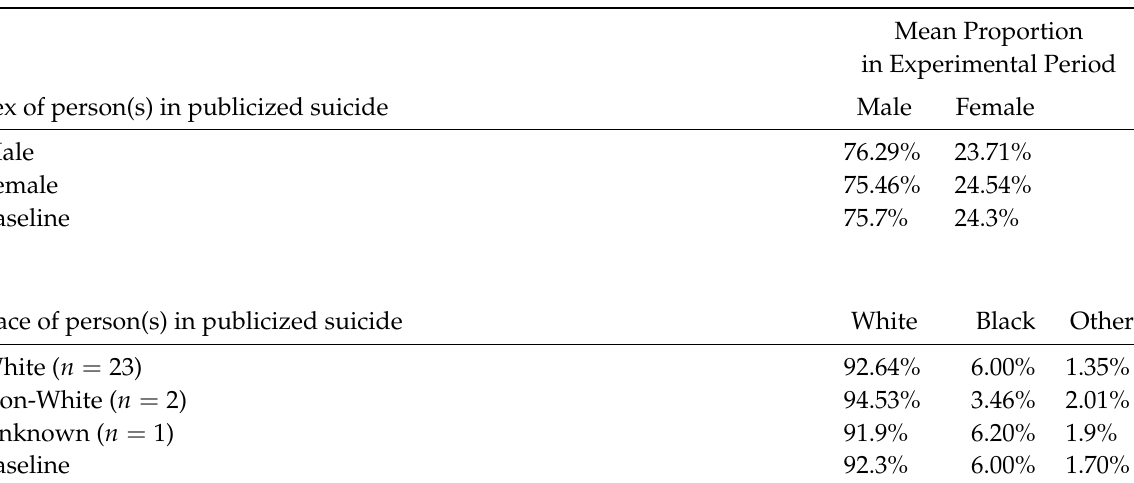
Table 6: Homophily by Social Demographic Characteristics